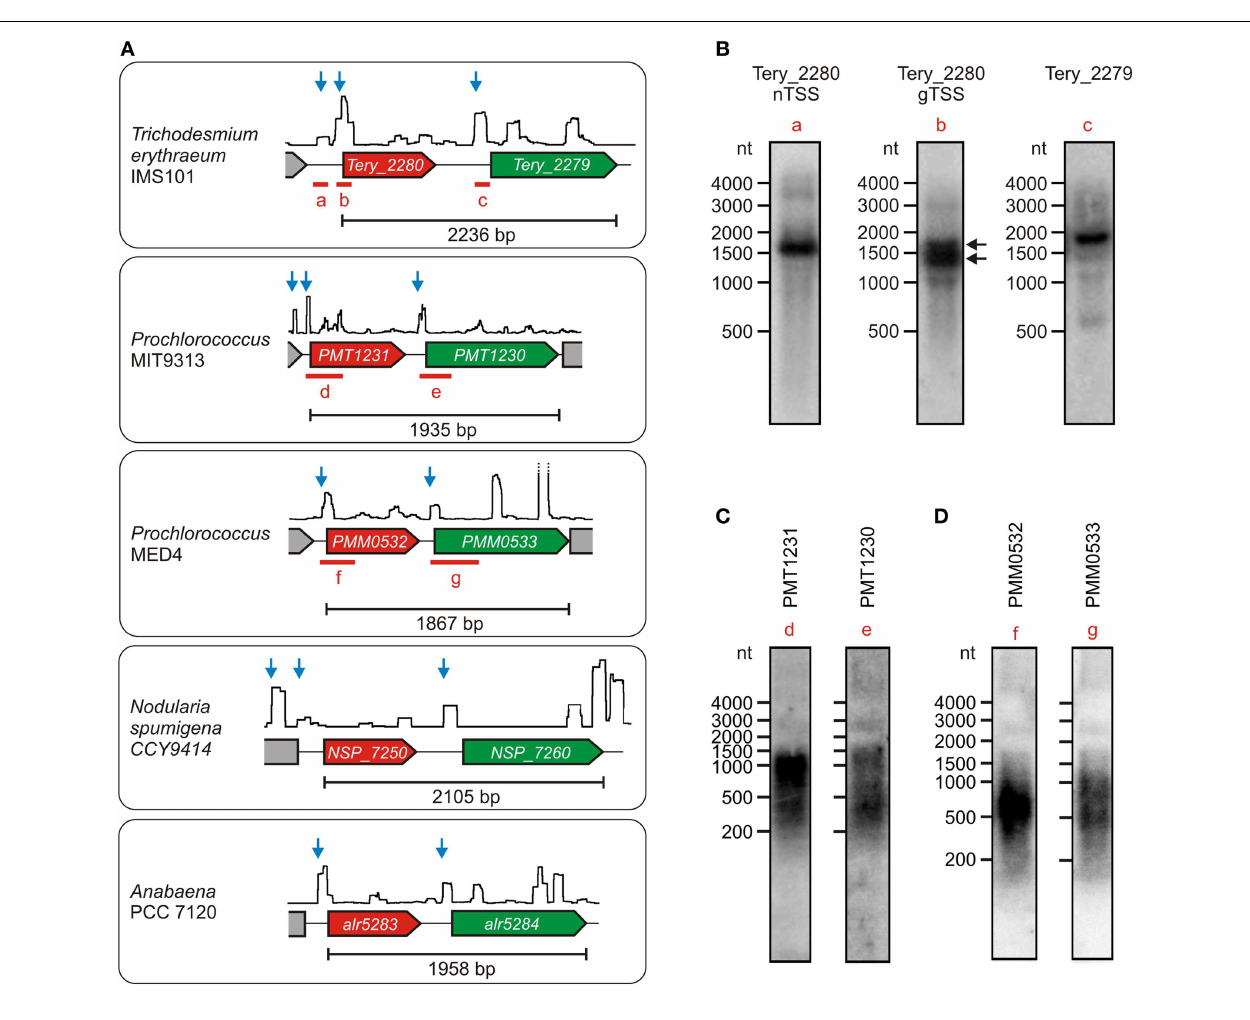
arrangement is given for the sequence between the start codon of ado and the stop codon of aar . (B) Northern verification of ado (Tery_2280) and aar (Tery_2279) mRNAs in Trichodesmium erythraeum IMS101.The black arrows indicate the two mRNAs originating from the independent TSS upstream ofTery_2280. (C,D) Respective northern blots for both mRNAs in Prochlorococcus sp. MIT9313 and MED4.The corresponding probe loci are given in (A)